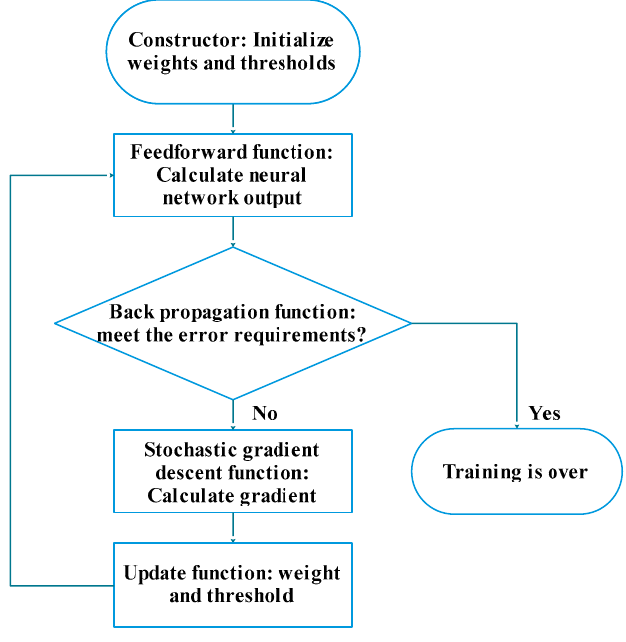
Figure 9. Neural network model training flow chart.